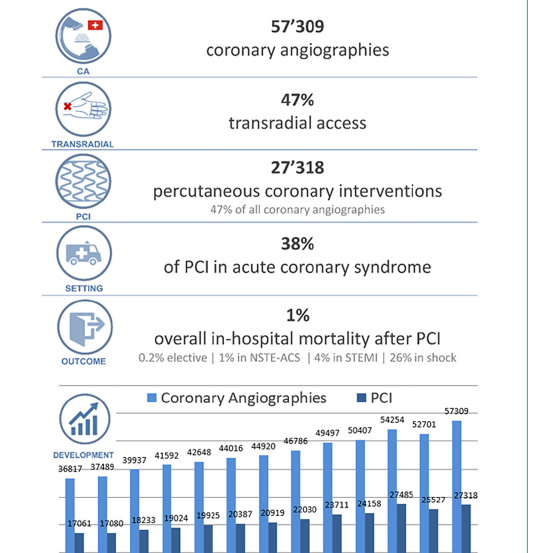
Figure 2: Coronary interventions in Switzerland: summary 2018 and development 2006–2018. CA = coronary angiography; PCI =